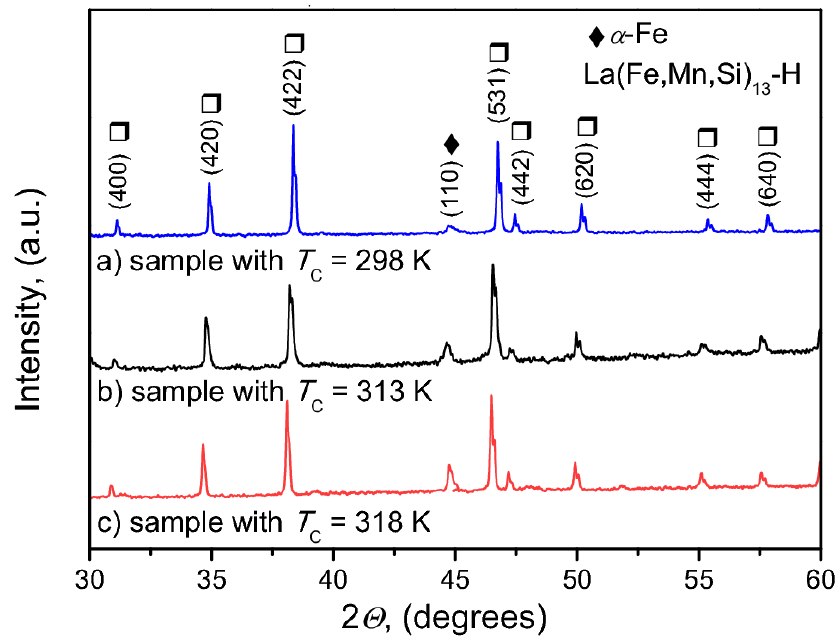
Figure 8. The XRD patterns for the considered La(Fe,Mn,Si) 13 -H samples.